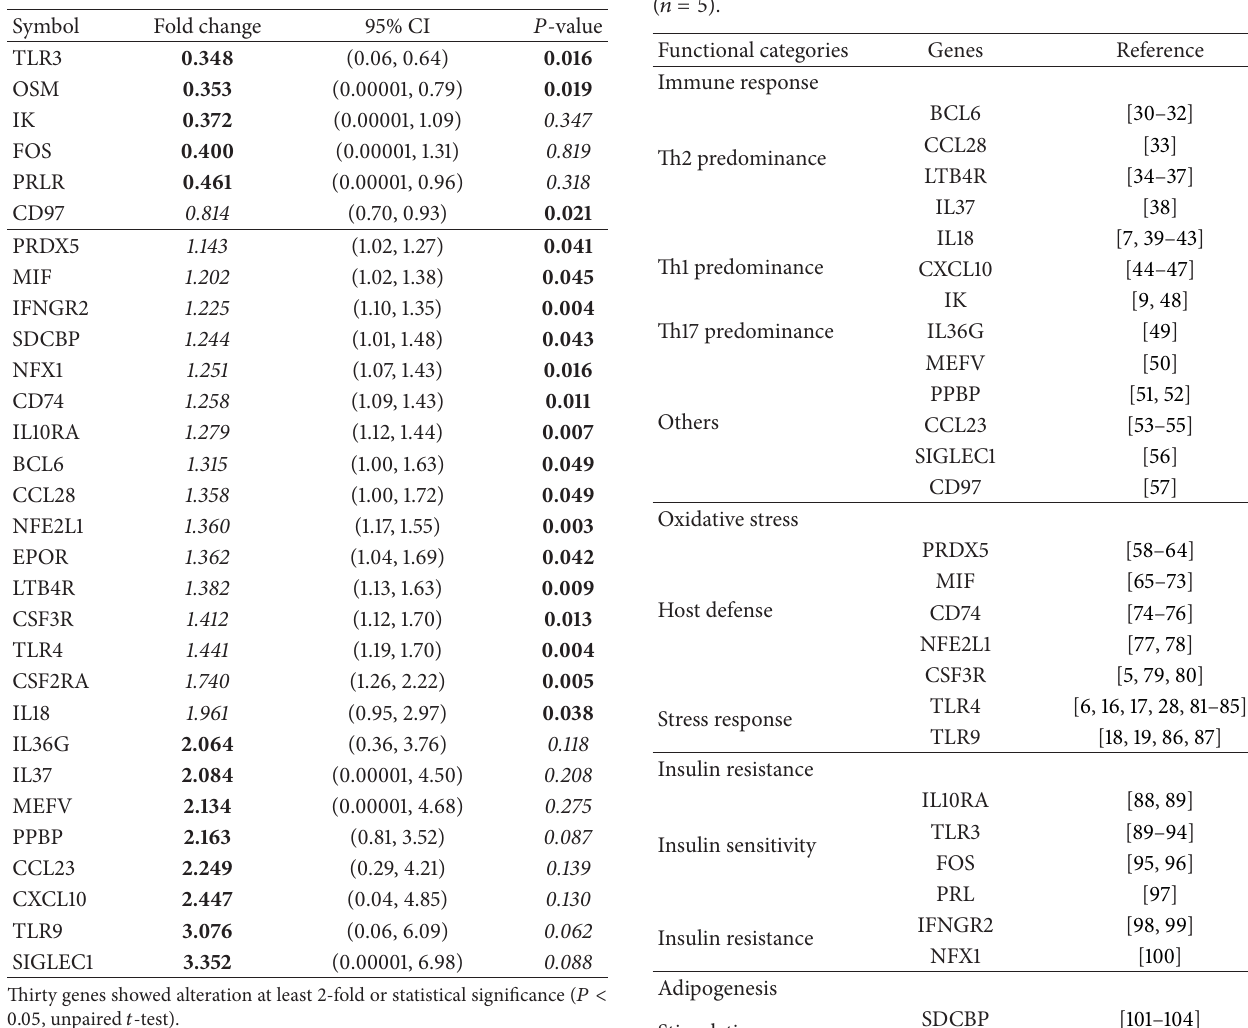
Table 2: Genes identified with altered expression in adipose tissues treated with preeclampsia sera.